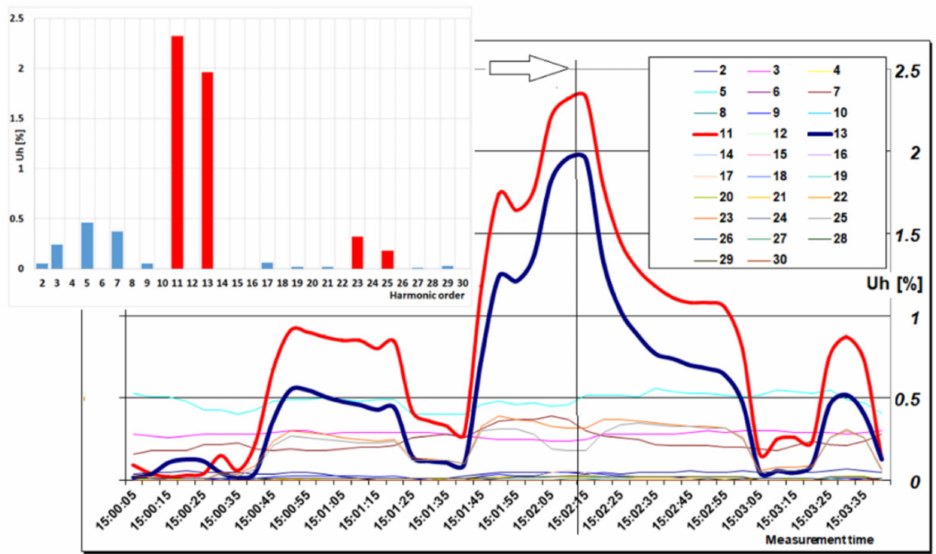
Figure 18. Spectrum of voltage harmonics during starting process of the